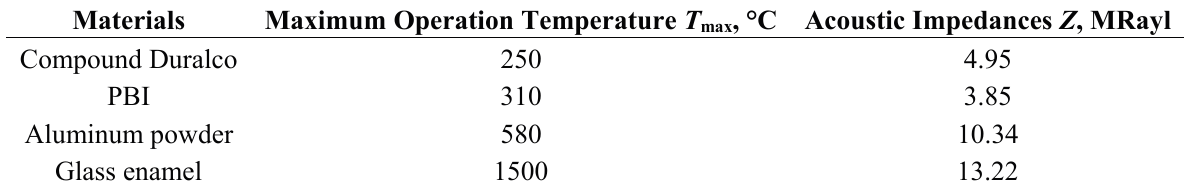
Figure 2. The reflection coefficient R 3 versus the density of the medium ρ 3 contacting the tip of the different waveguides (estimated from modelling): ( a ) without matching layer: 1, titanium waveguide; 2, steel waveguide; ( b ) with the λ /4 matching layers: 1, titanium waveguide with the polybenzimidazole (PBI) matching layer; 2, titanium waveguide with the Duralco matching layer; 3, steel waveguide with the aluminum powder matching layer; 4, steel waveguide with the glass enamel matching layer. Table 1. Properties of the